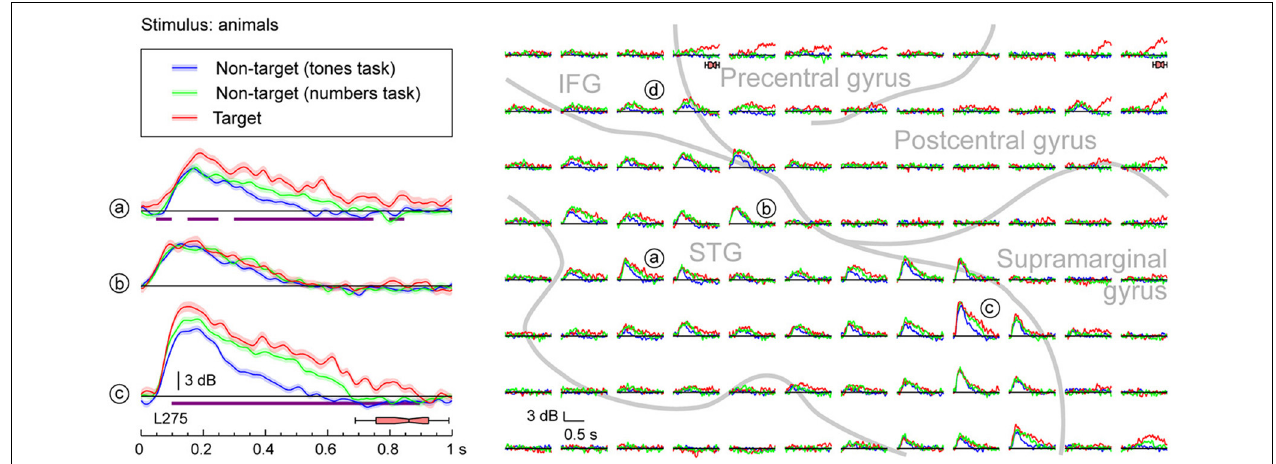
FIGURE 4 | Task effects on responses to speech stimuli (animals) in PLST. High gamma responses to speech sounds representing animals, presented in three different tasks (different colors), are shown for three